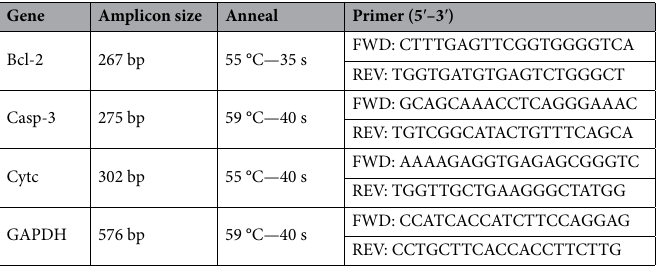
Table 4. List of primers used for sqRT-PCR amplifications. Bcl‑2 B-cell lymphoma 2, Casp‑3 Caspase-3, Cytc Cytochrome-c, GAPDH Glyceraldehyde 3-phosphate